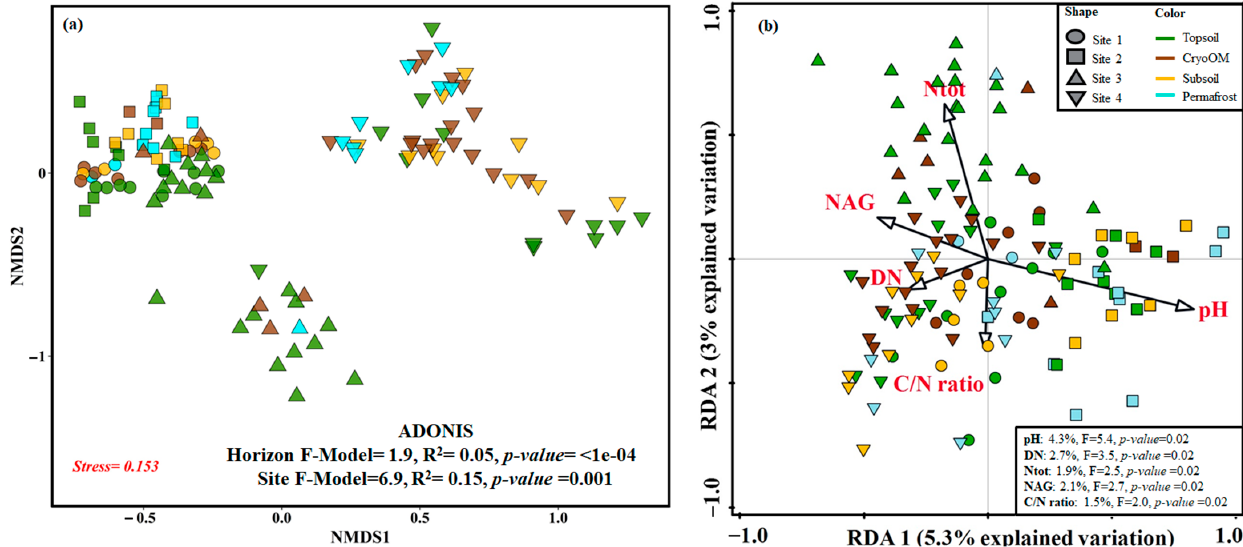
Figure 2. The phylogenetic dissimilarity between soil horizons and tundra types. ( a ) NMDS of fungal communities of different horizons from distinct tundra types; ( b ) RDA biplot of fungal diversity and environmental factors. Significant effect of soil parameters (black arrow in figure) on fungal communities were identified by forward selection. The proportion of variability explained by significant soil parameters are given in the lower right corner.